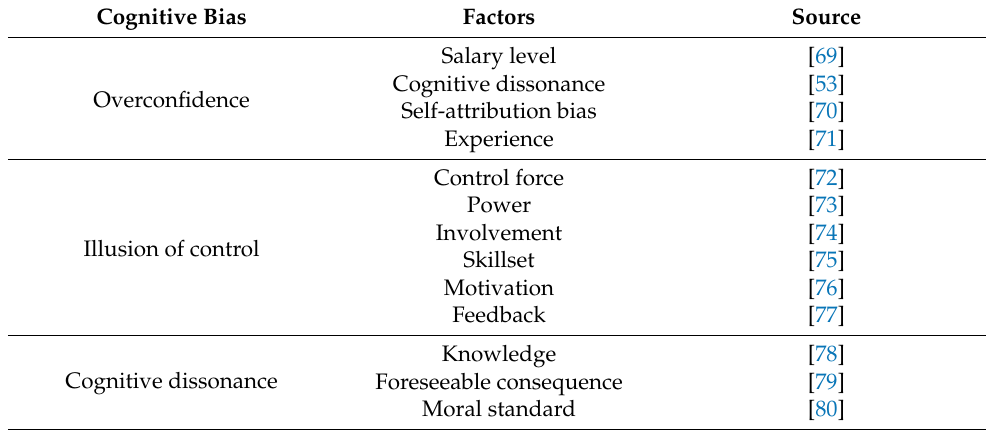
Table A2. Personal factor screening for conspirators’ cognitive